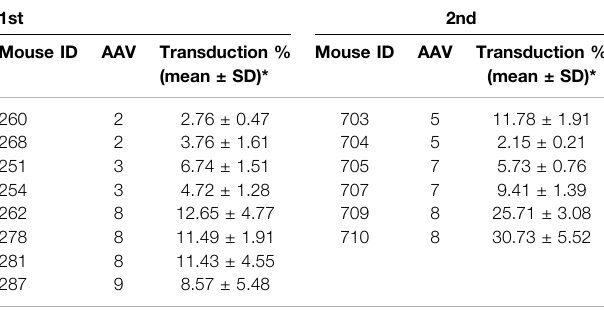
TABLE 1 | AAV vector transduction ef fi ciency of canine hepatocytes in canine xenograft mice. 1st 2nd